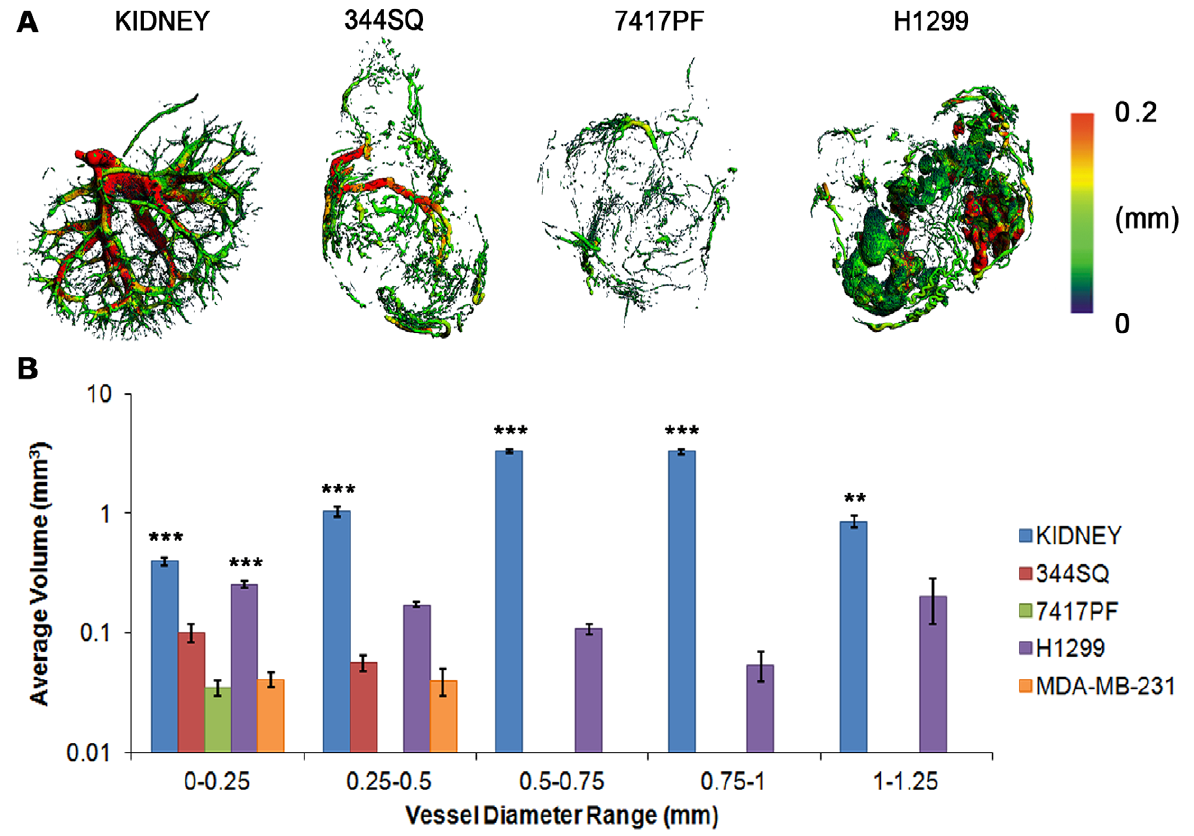
Figure 3. Quantification of vessel thickness. ( A ) 3-D renderings of vasculature (red = vessel diameters of 0.2 mm or greater) showing the organized kidney vasculature versus the disorganized, irregular vessel diameters in the NSCLC tumors (344SQ, 7417PF and H1299). ( B ) Quantification of vessel thickness of two human and two murine cell lines over the entire spectrum of vessel diameters, showing very significant differences between normal and tumor vasculature, with most of the tumors only having vessels up to 0.5 mm, while the kidneys had vessels up to 1.25 mm in diameter (note the log scale on Y axis).